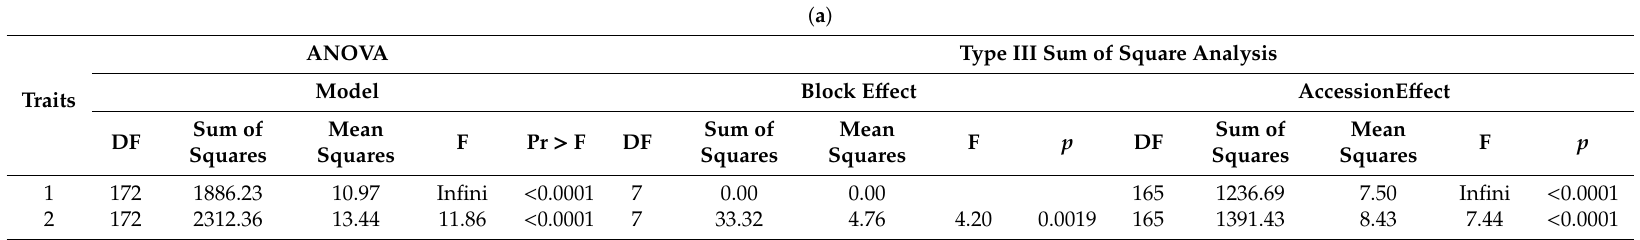
Table 4. ( a ) Analysis of variance (ANOVA) and type III sum of squares analysis for the selected quantitative traits * at the Tanzania Co ff ee Research Institute (TaCRI, Kilimanjaro region) during the 2019 cropping season; ( b ) analysis of the di ff erences and interactions between accessions and checks for the selected traits (all species) at the Tanzania Co ff ee Research Institute (TaCRI, Kilimanjaro region) during the 2019 cropping